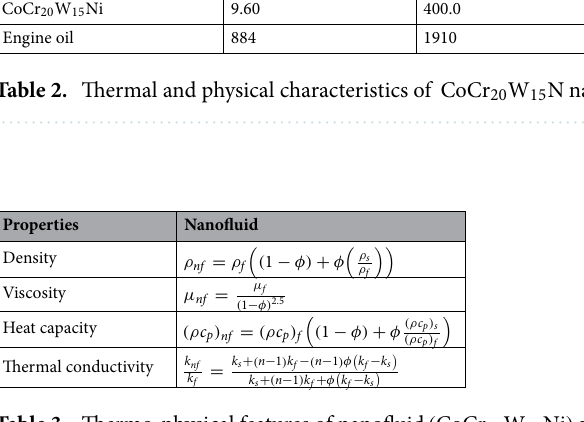
Table 3. Thermo-physical features of nanofluid ( CoCr 20 W 15 Ni ) and engine oil (EO).